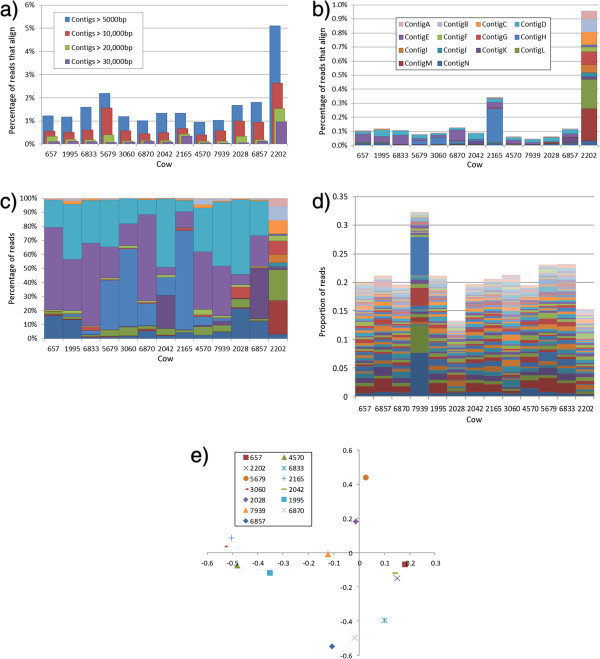
Between animal variation in alignments to contigs. a) Percentage of reads that map back to assembled contigs of different sizes. b) Distribution of reads that map to the 14 contigs annotated in Figure 1. c) Distribution of reads that map to the 14 contigs annotated in Figure 1 normalised to a total of 100%. d) Distribution of reads that map to the 100 most abundant (in our dataset) contigs assembled from [8]. e) Principle component analysis of reads that map to the 50 most abundant contigs assembled from [8]. PC1 (X axis) explains 15.42% of the variation, PC2 (Y axis) explains 12.73% of the variation.